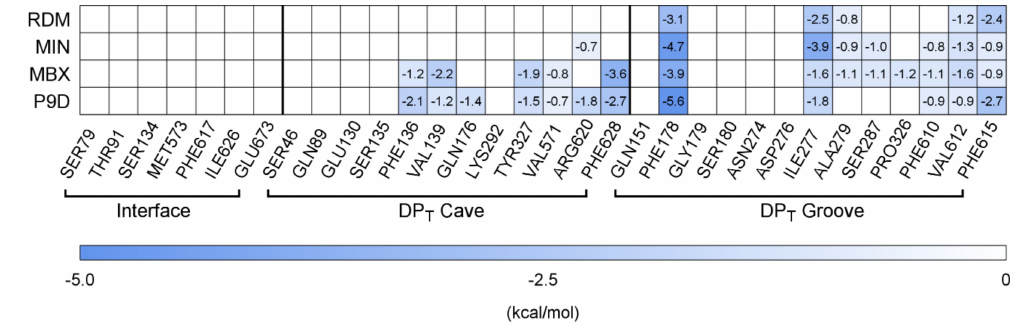
Figure 3. Per-residue contributions to the free-energy of binding (kcal / mol) evaluated for the considered substrates and inhibitors co-crystallized with AcrB. Only residues contributing more than kT (~0.6 kcal / mol at 310 K) are reported. Residues of the interface, DP T cave and DP T groove are colored with di ff erent tones of blue according to their individual contribution to the overall ∆ G b